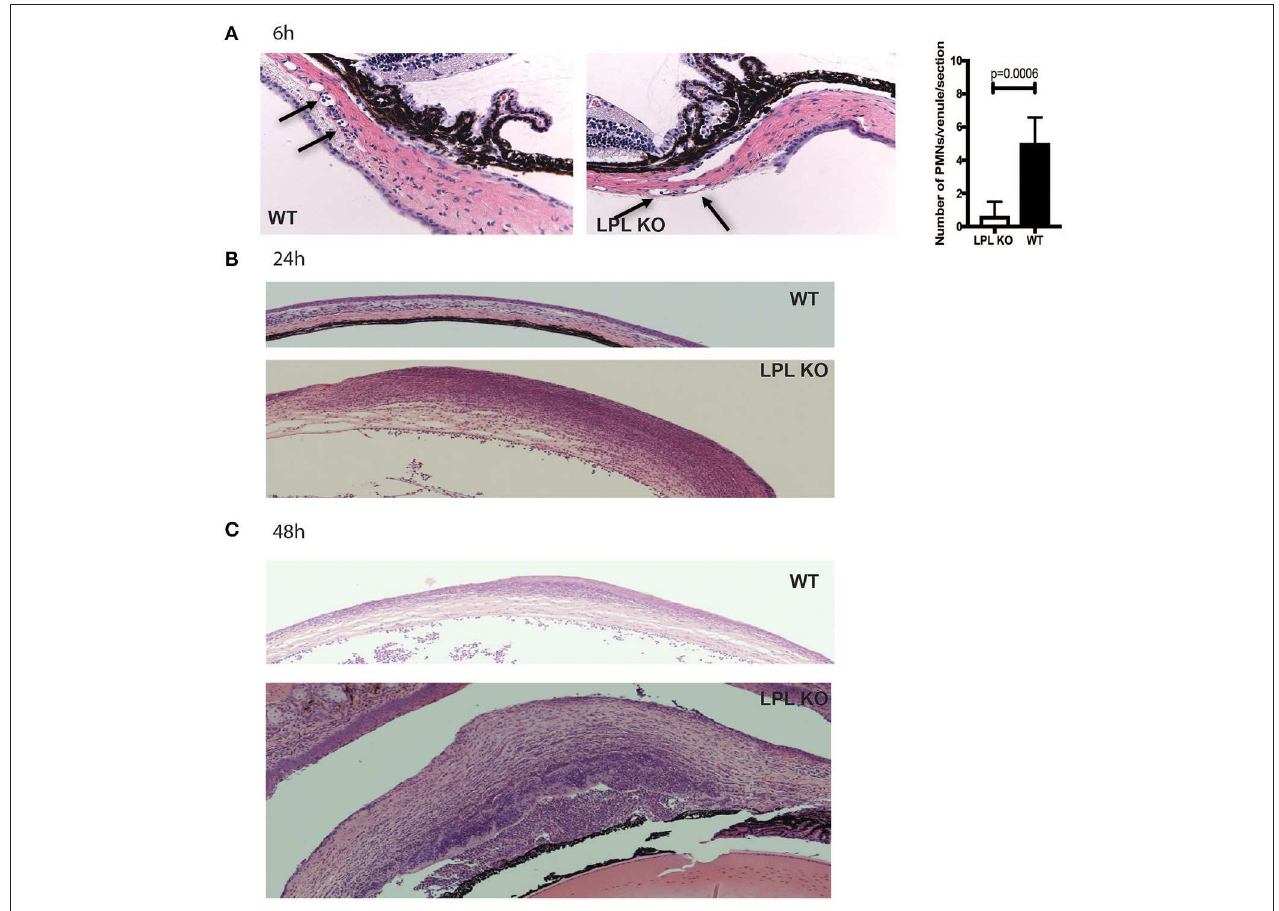
WT mice at 6 (A) , 24 (B) , and 48h (C) post-challenge. Arrows point to PMNs present in conjunctival capillaries of the infected animals. Vessel-associated neutrophils were counted in 3 sections per mouse and averaged among 7 animals to gain insight into early neutrophil infiltration. Student’s t -test. p = 0.006. Data